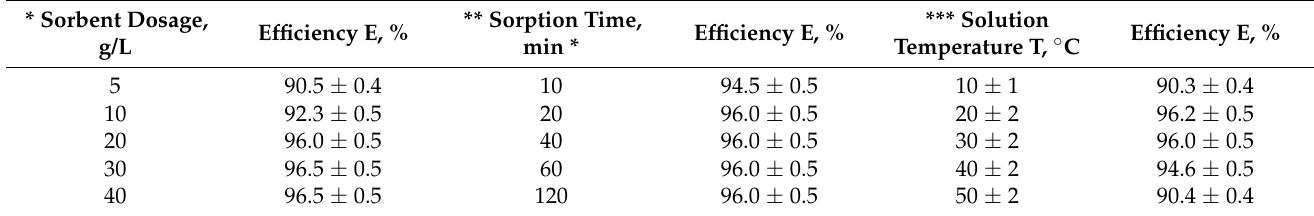
Table 3. Relationship between the sorbent dosage, time, and temperature of sorption and the efficiency of purification of copper cations by the GO-Ch sorbent (sample No. 4).